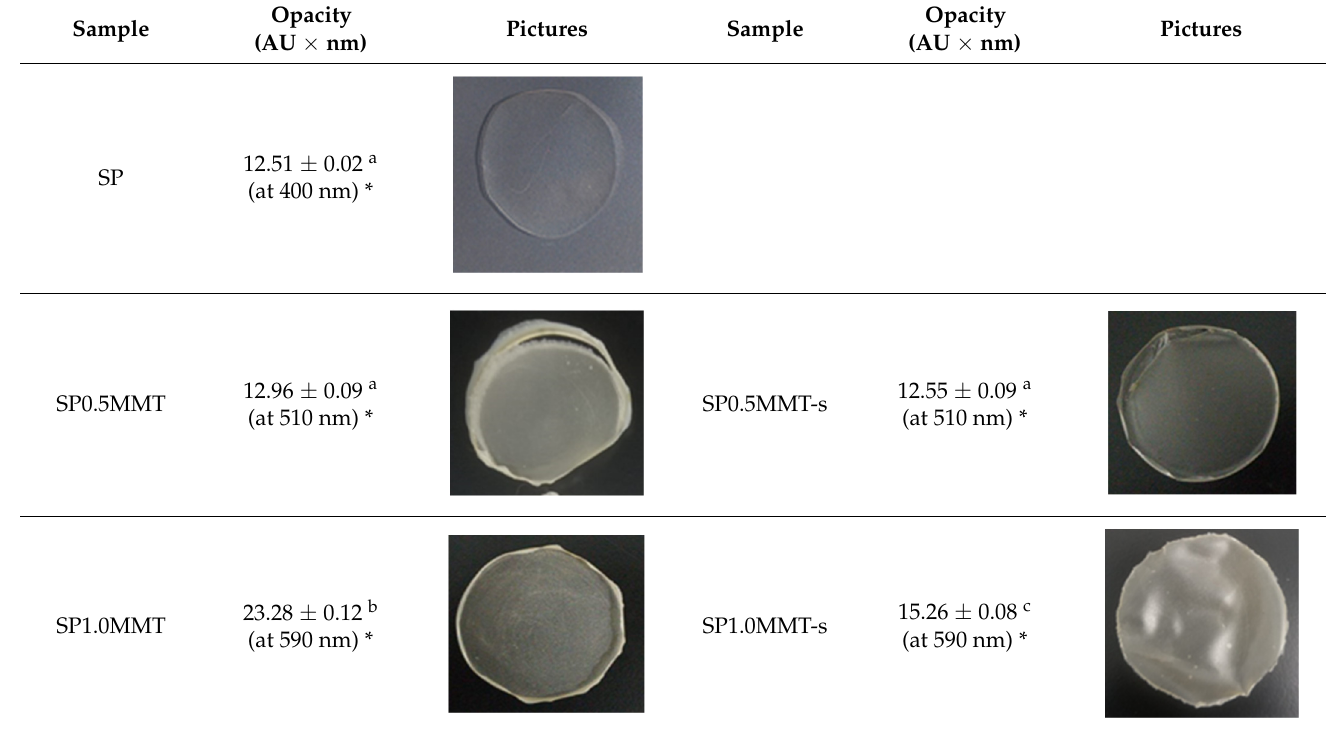
Table 1. Opacity values and real images of the appearance of the SP films to the human eye of polymeric bionanocomposite films.